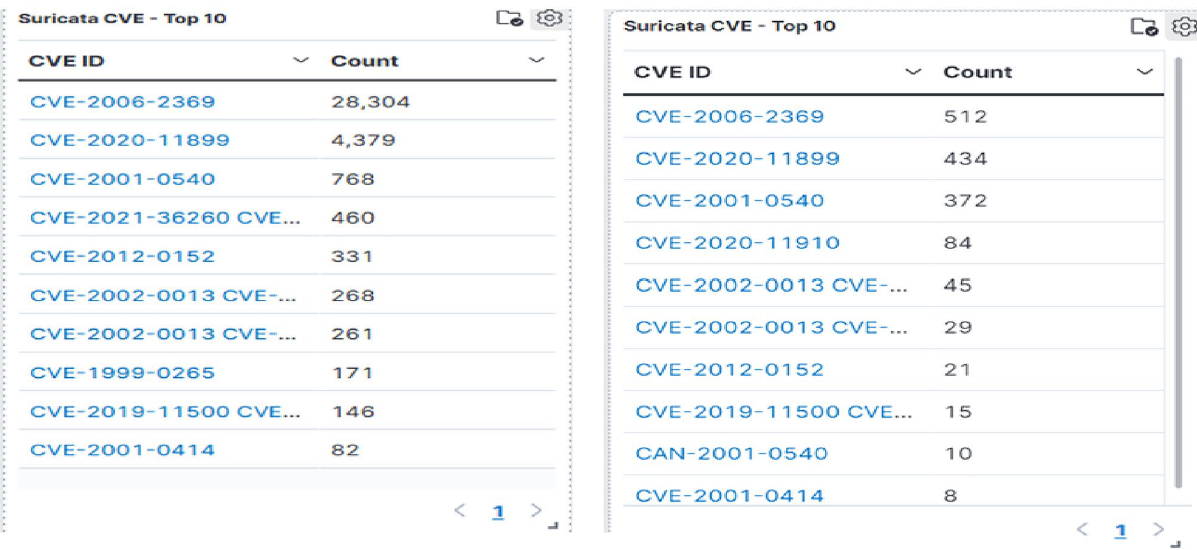
Figure 11. Details of top CVEs identified by the honeypot